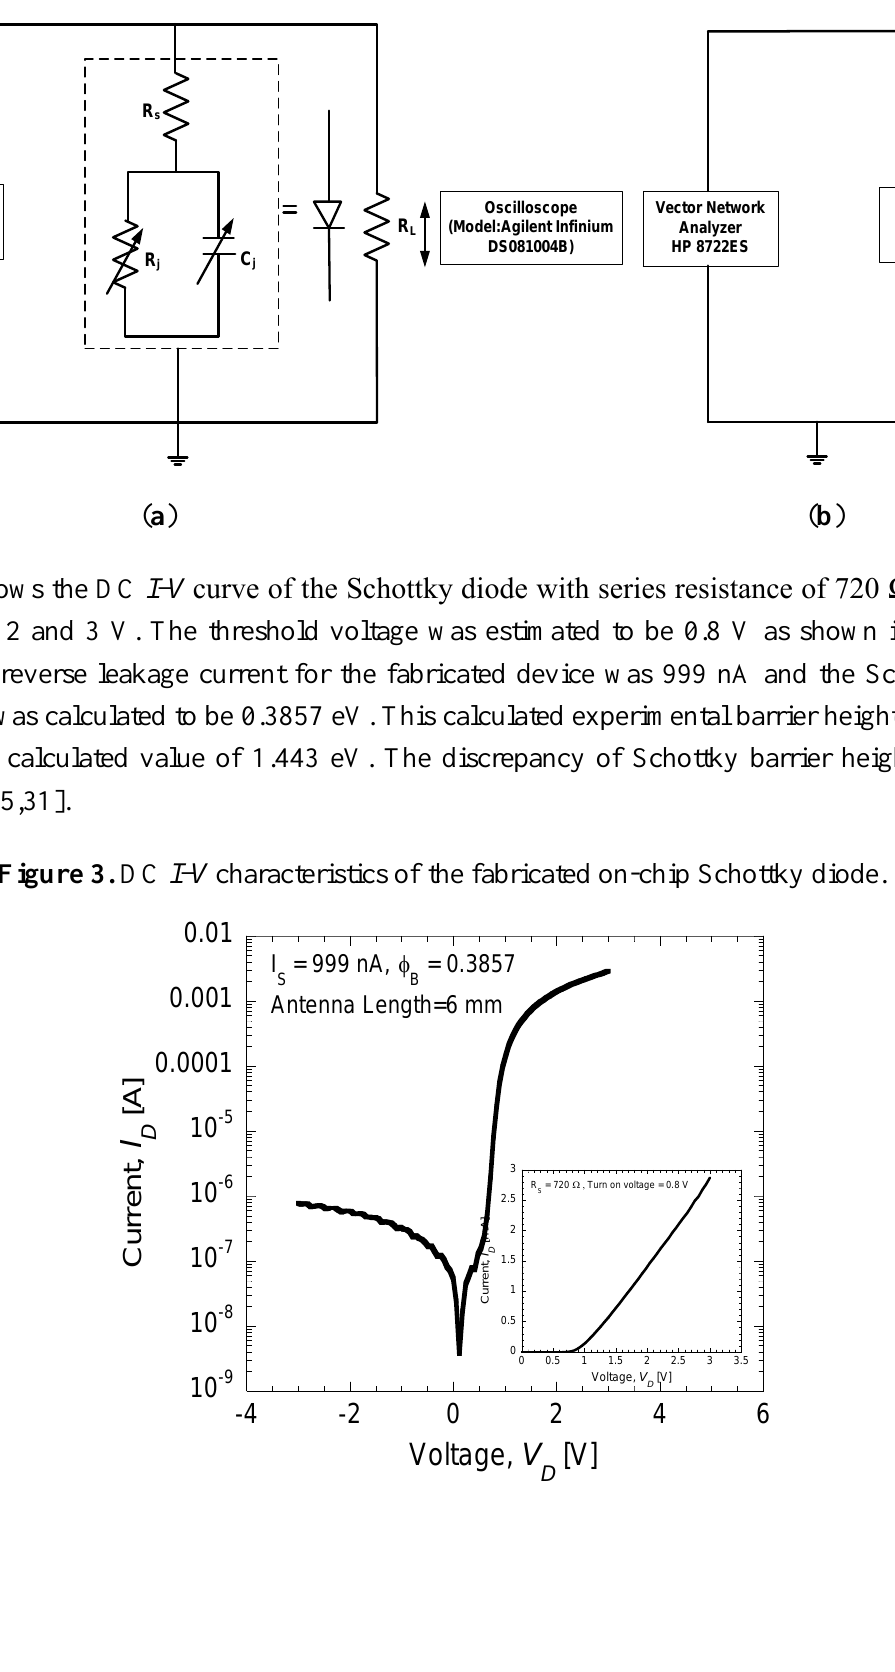
Figure 2. The circuit configuration for: ( a ) the Schottky diode and ( b ) the dipole antenna in direct injection experiment.